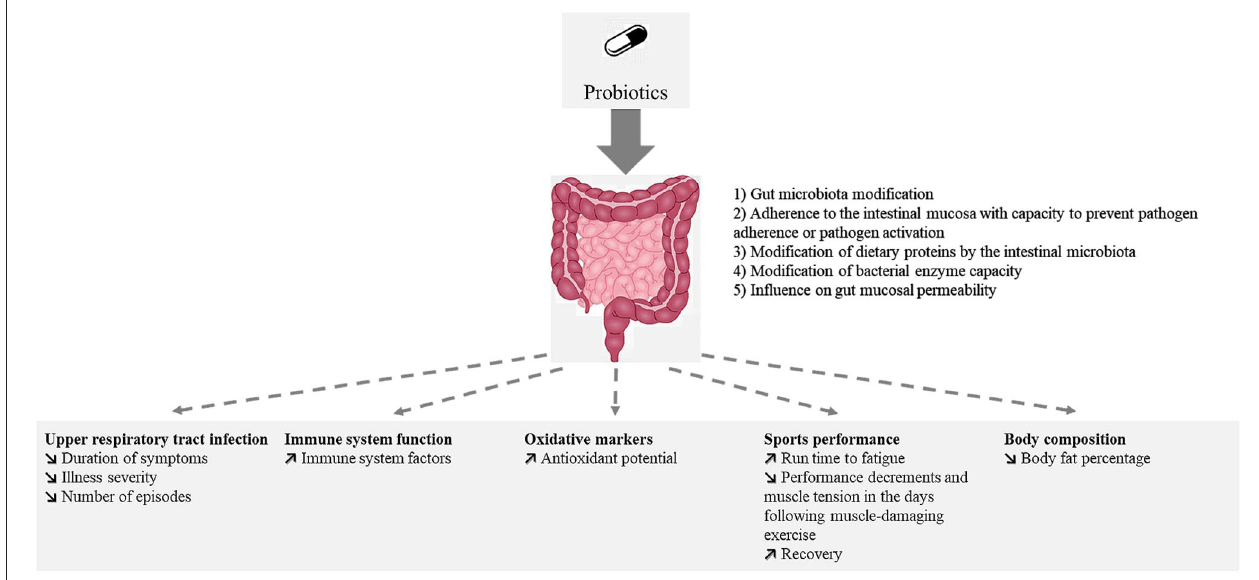
FIGURE 3 | Reported effects of probiotic ingestion by athletes or subjects practicing moderate physical